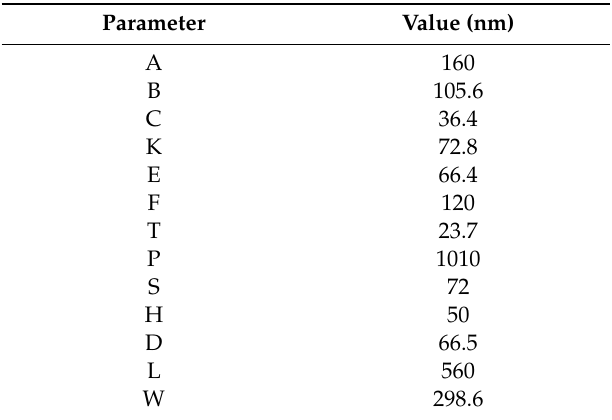
Table 1. The simulation is performed on a finite integration technique (FIT)-based ‘CST Microwave Studio’ simulation environment. Table 1. Structural parameters for proposed unit cell construction. Table 1. Structural parameters for proposed unit cell